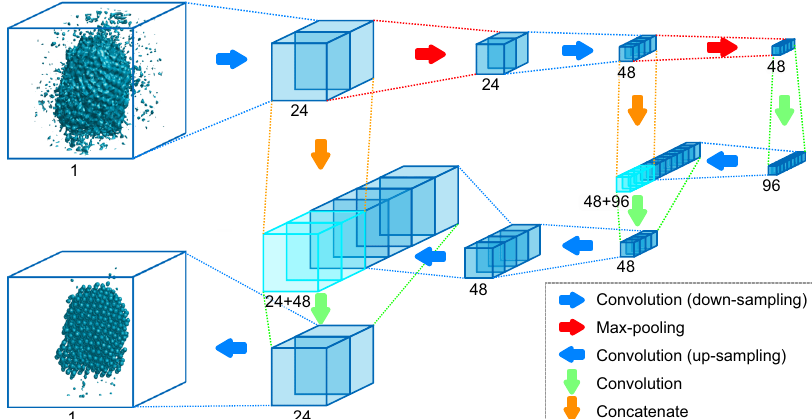
Fig. 1 The architecture of the deep learning augmentation. The deep learning augmentation follows a 3D-unet structure (see “ Methods ” section). The set of boxes represents the feature map. The number of channels is denoted below each feature